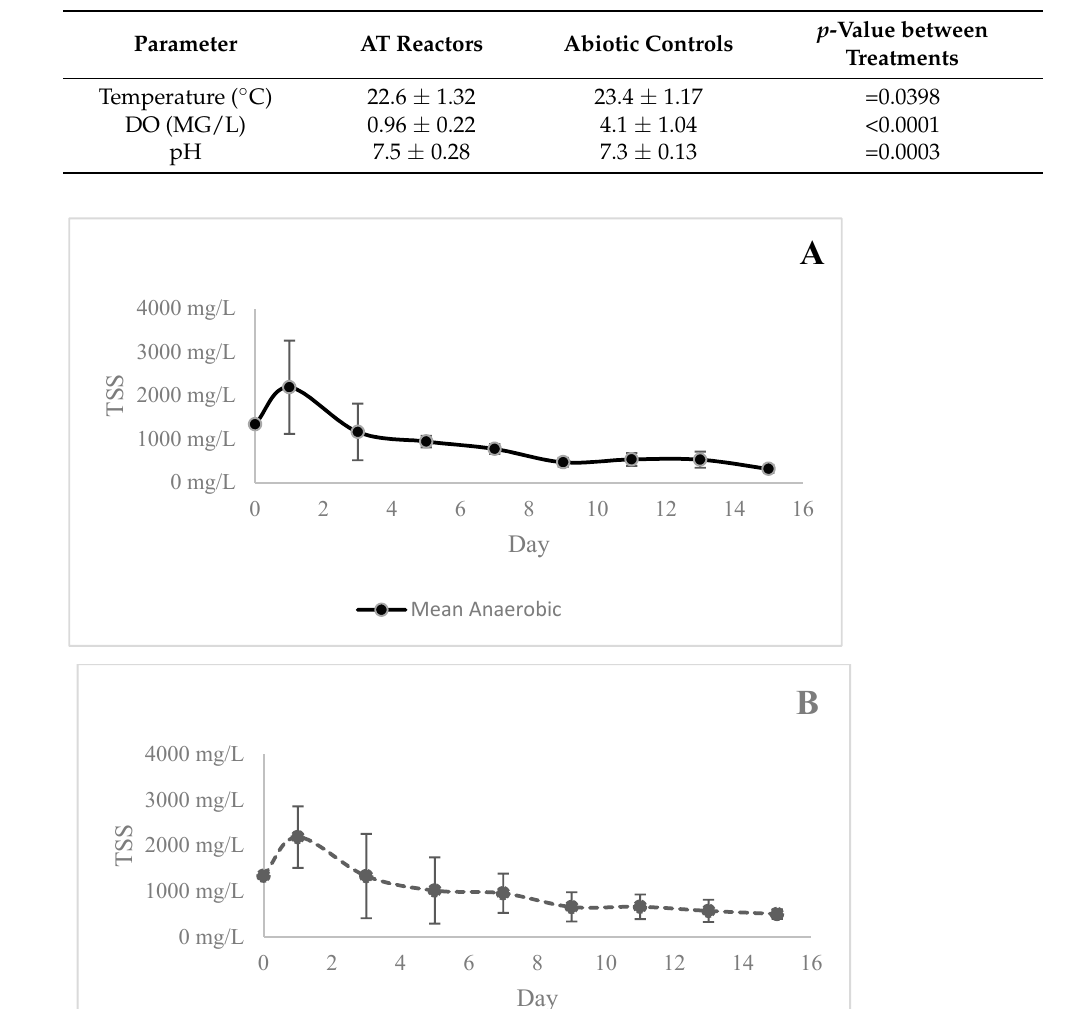
Figure 3. Reactor ORP. Mean ORP within the control (dash line) and anaerobic (solid line) replicates throughout the 15-day study period. Error bars indicate standard deviation between treatment replicates.